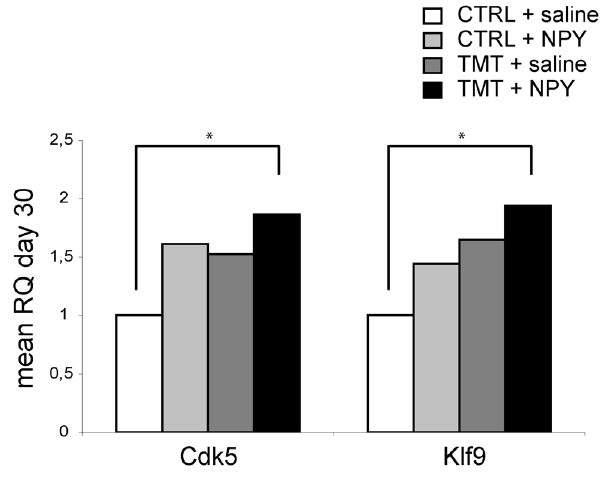
Figure 5. mRNA expression levels of Klf9 and Cdk5 in rat hippocampus in the different experimental groups. Results of quantitative real time-PCR obtained using the DD Ct method for calculation of the relative quantity (RQ) of Cdk5 and Klf9 genes tested 30 days after NPY administration. *p , 0.05, calculated on mean D Ct across biological